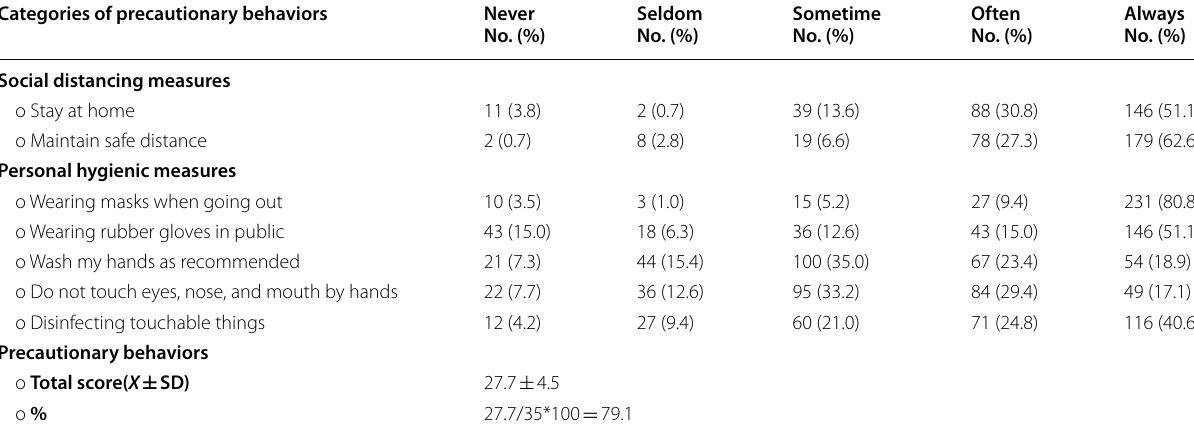
Table 1 Responses to COVID-19 precautionary behaviors among the students of health sciences in Princess Nourah University, 2020 ( n 286) =